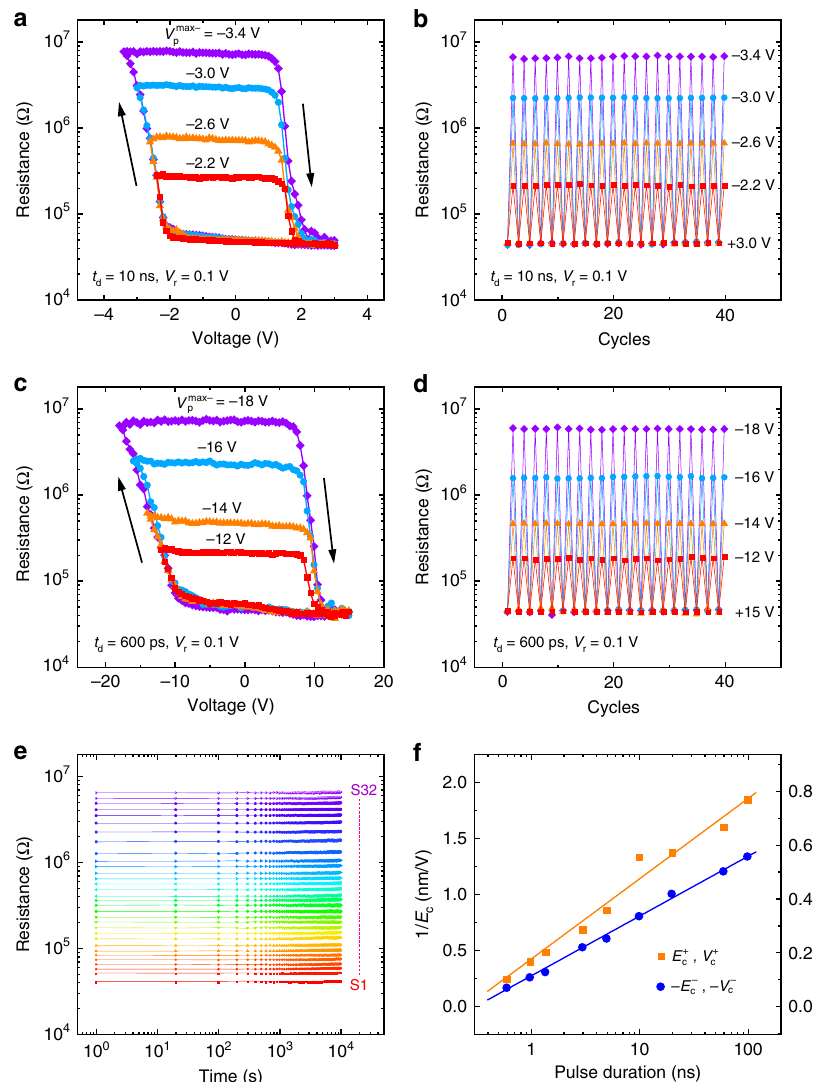
Fig. 2 Ultrafast resistance switching at room temperature. a Resistances measured at 0.1 V as a function of V p with t d = 10 ns. b Typical resistance switchings between the ON state and different high-resistance states measured at 0.1 V after applying voltage pulses with t d = 10 ns. c Resistances as a function of V p with t d = 600 ps. d Typical resistance switchings between the ON state and different high-resistance states with t d = 600 ps. The arrows in a and c represent the direction of pulse sequence. e Resistance retentions for 32 distinct resistive states. f Inverse of coercive electric fi eld (coercive voltage) 1/ E c (1/ V c ) versus pulse duration. The solid lines are the linear fi tting